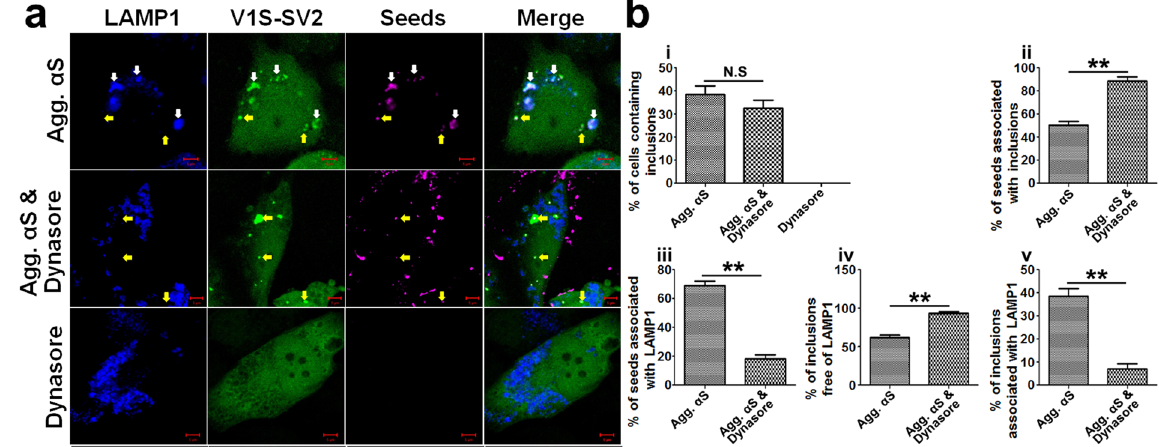
Figure 3. Membrane penetration- and endocytosis-mediated α S seeding contribute to formation of endo- lysosome-free and endo-lysosome-associated α S inclusions. ( a ) H4/V1S-SV2/LAMP1-eCFP cells were respectively treated with DyLight ® 650 labeled α S seeds (Agg. α S), Dynasore, and Dynasore & Agg. α S for 2 days followed by imaging under confocal microscopy. The concentration for Agg. α S is 0.5 µ g/ ml, and Dynasore 20 µ M. Yellow and white arrows denote α S seeds and induced LAMP1-free (yellow), LAMP1-positive (white) α S inclusion, respectively. Scale bar: 5 µ m. ( b ) Bar graphs show the comparisons among Agg. α S, Dynasore, and Dynasore & Agg. α S treated cells in the ratio of cells with inclusions to total cells, inclusions to total seeds, LAMP1-positive seeds to total seeds, LAMP1-negative and LAMP1-positive inclusions to total inclusions, respectively. Error bars represent standard error of the mean (N.S = non-significant; ** p < 0.01, comparing subsets linked by line, n =